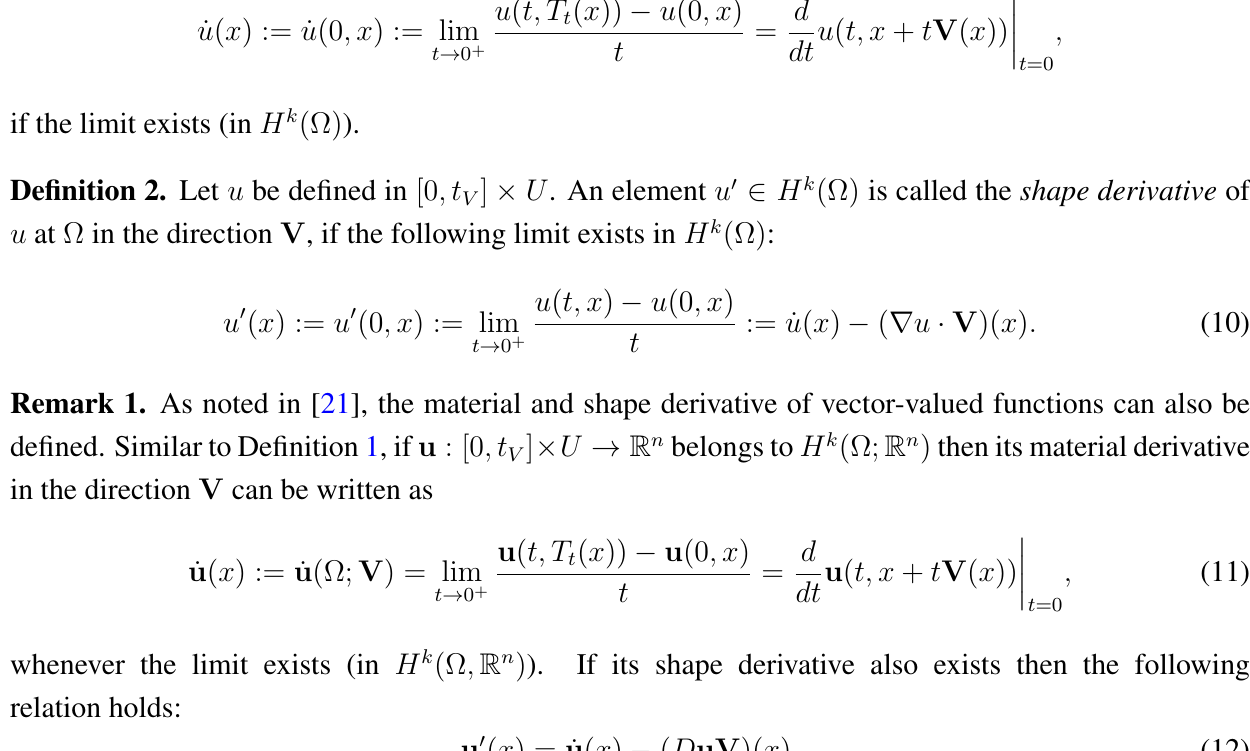
Figure 1. The difference between domains Ω